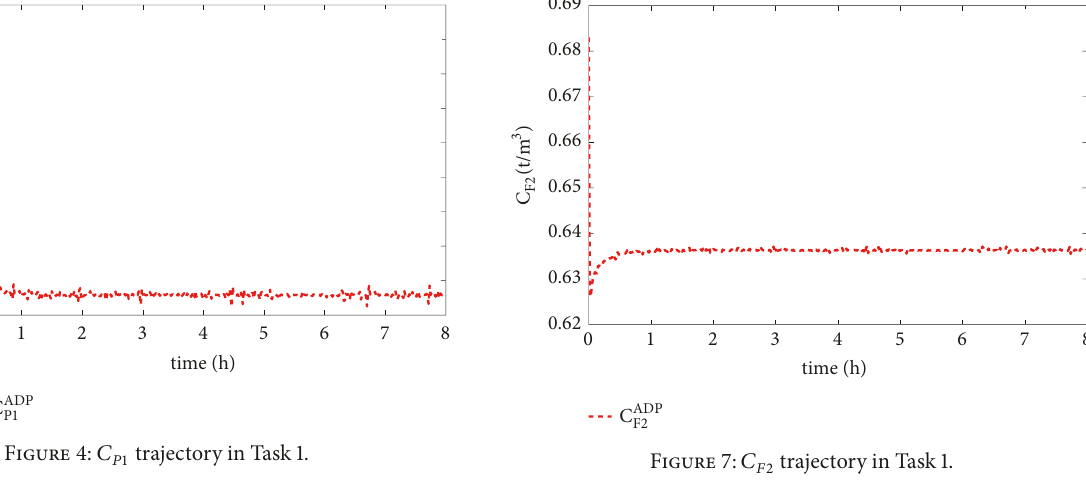
Figure 7: 𝐶 𝐹2 trajectory in Task 1.